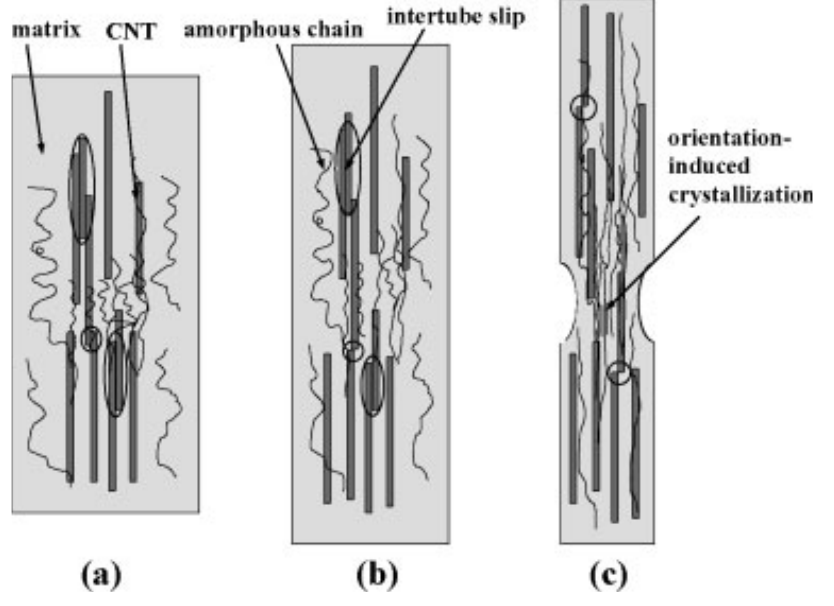
Figure 13. Schematic deformation model and orientation-induced crystallization of PP/CNT composite under uniaxial stress: (a) before loading, (b) under small load levels, and (c) under high load levels. Reproduced with permission from ref.